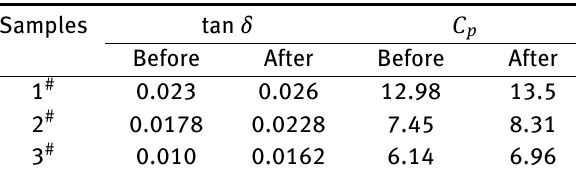
Table 1: Value of C p and (b) tan δ before and after electric degrada- tion